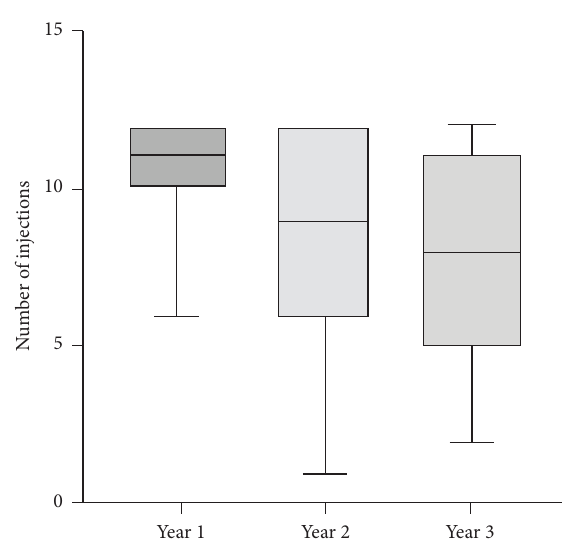
Figure 4: Number of injections admitted to patients who com- pleted the study in the frst, second and, third